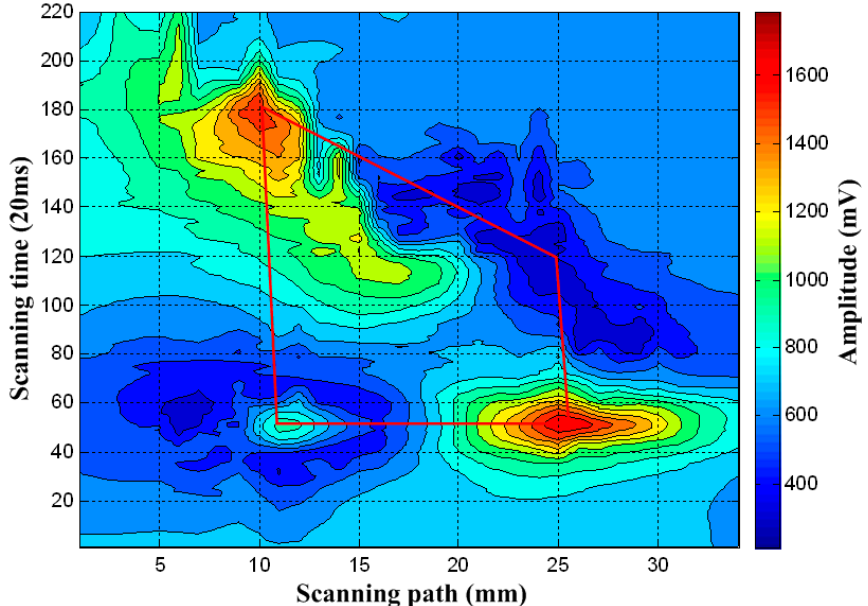
Figure 15. C-scan contour images of irregular defect 4.